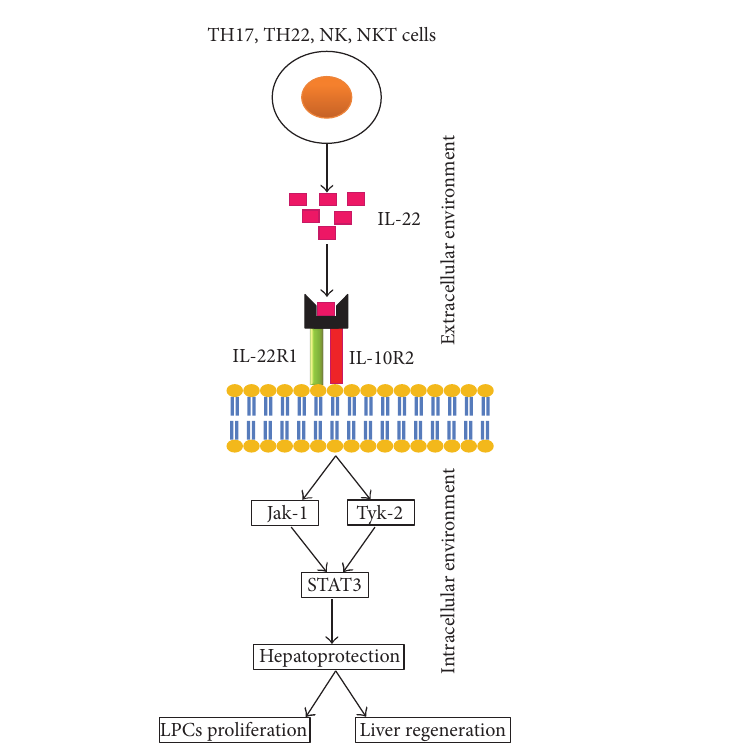
cells by enhancing the expression of antioxidative genes